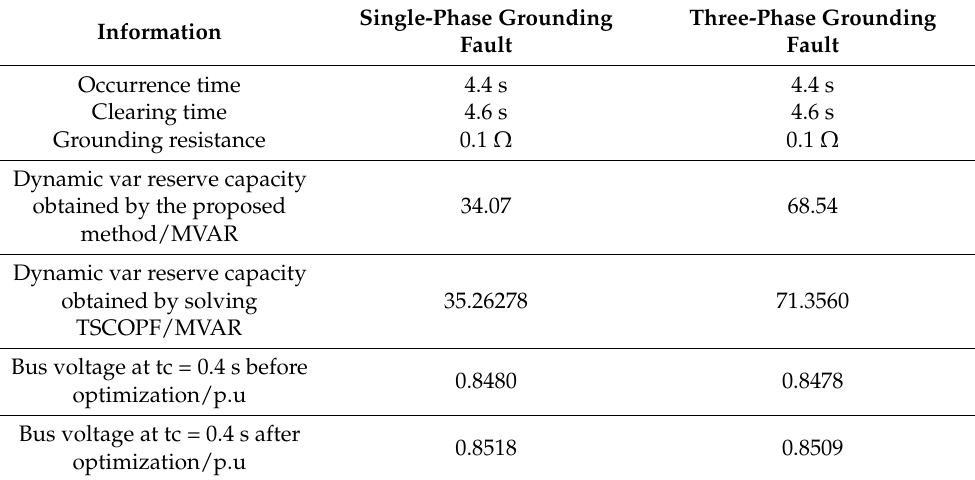
Table 3. Detailed fault information and results of dynamic var reserve assessment in case study.